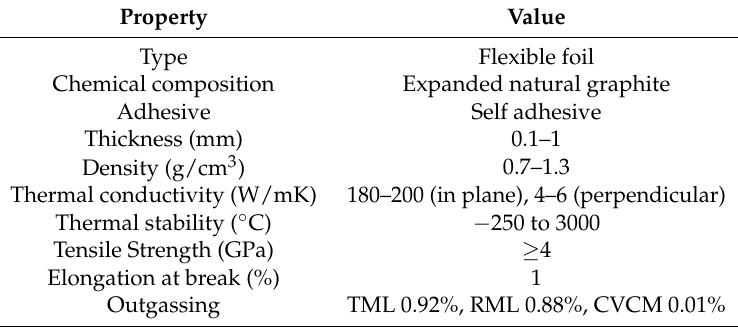
Table 7. Typical properties of Sigraflex